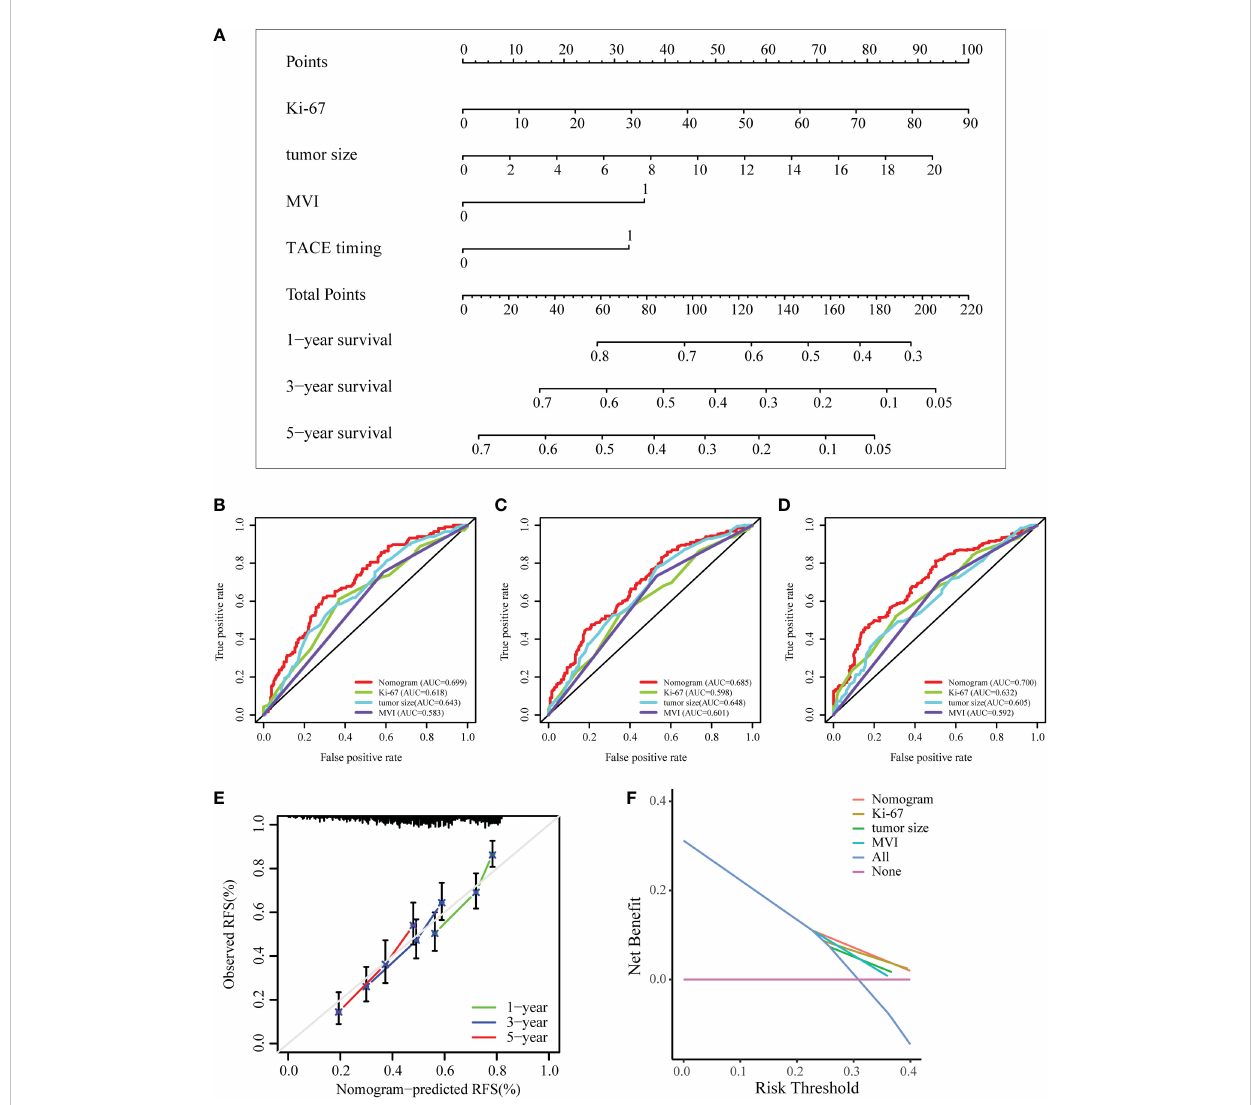
FIGURE 4 Development and validation of a nomogram for the prognosis of HCC. (A) Nomogram to evaluate the prognosis of HCC for RFS. (B – D) ROC curves of the model predicting the 1-, 3- and 5-year RFS of HCC patients. (E, F) The calibration plot and DCA of the nomogram for RFS. ROC, receiver operating characteristic curve; DCA, decision curve analysis; MVI, microvascular